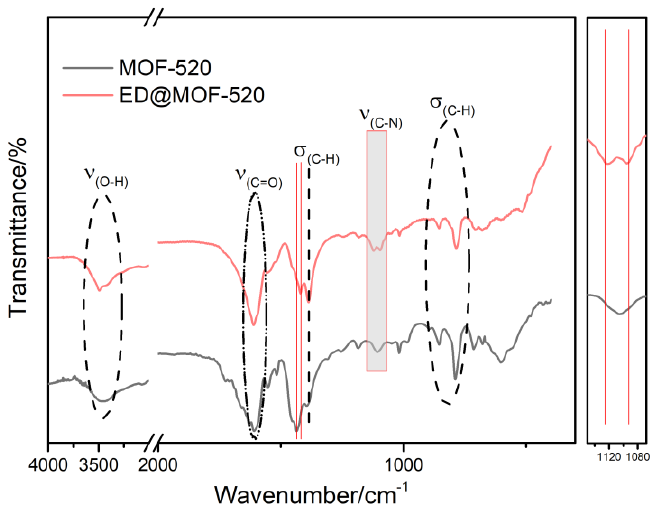
Figure 4. FT-IR results of samples. Table 1. The summary of BET data and elements content of C, H, and N of samples.